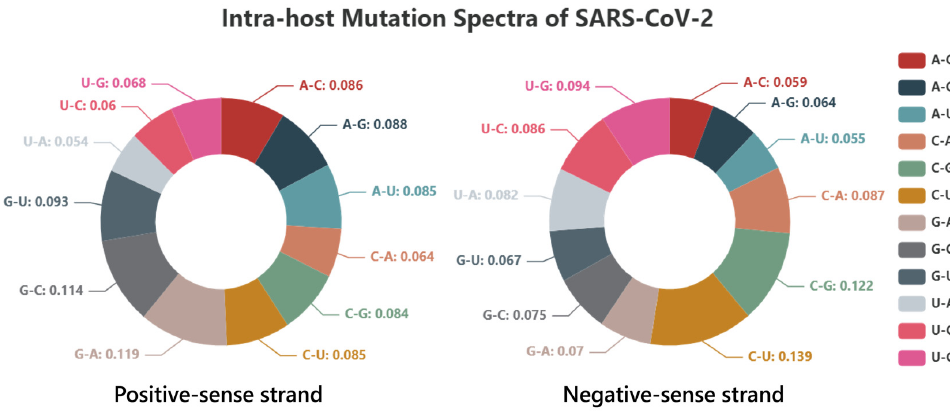
Figure 5. Intra-host mutation spectra of SARS-CoV-2. The size of each color in the pie chart indicates the proportion of the corresponding base mutation type within the intra-host mutation spectra.